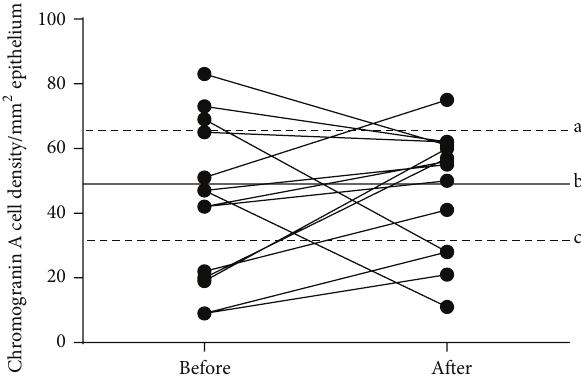
Figure 3: CgA cell density in the rectum of IBS patients before and after receiving dietary guidance. The symbols are the same as in Figure